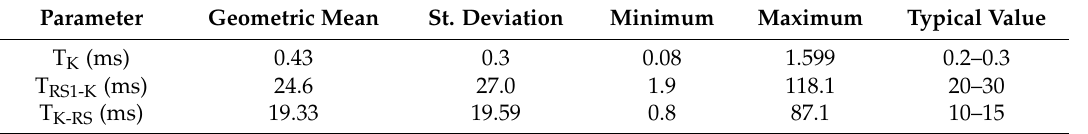
Table 2. Summary of the statistics for parameter distributions in Figure